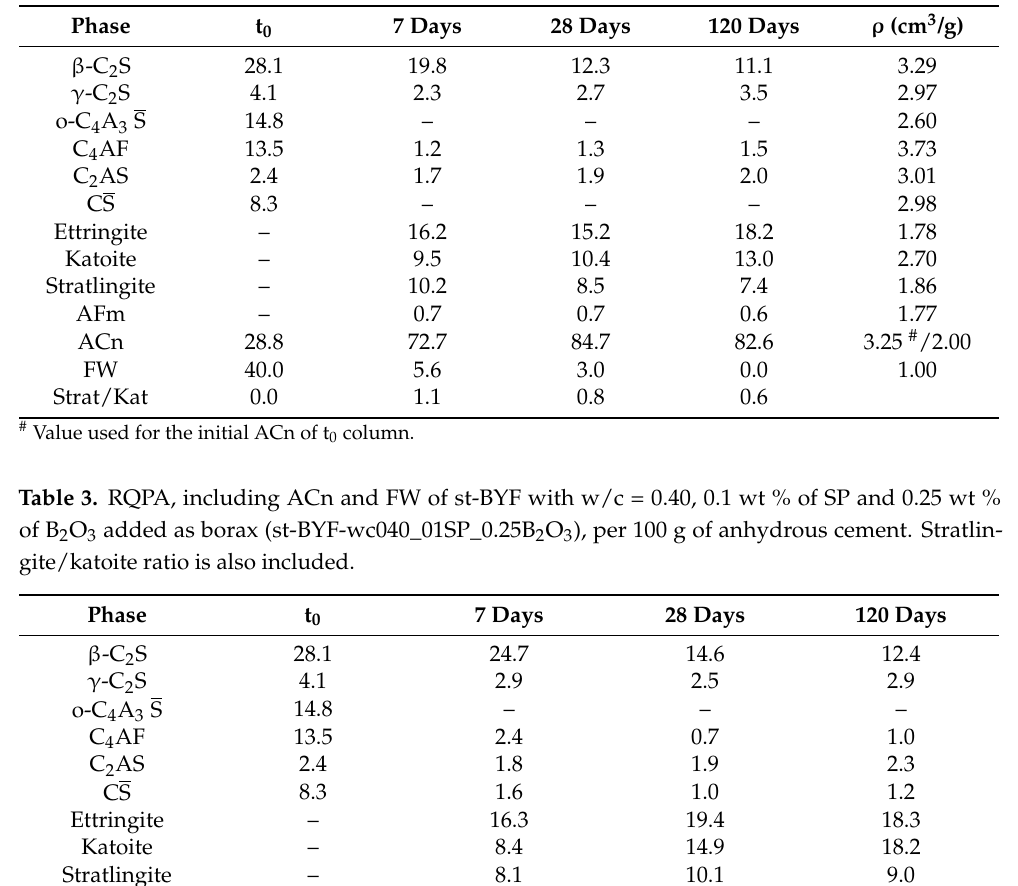
Table 2. RQPA, including ACn and free water (FW) of st-BYF with w/c = 0.40 and 0.3 wt % of SP (st-BYF-wc040_03SP), per 100 g of anhydrous cement. Density of all phases and stratlingite/katoite ratio are also included.